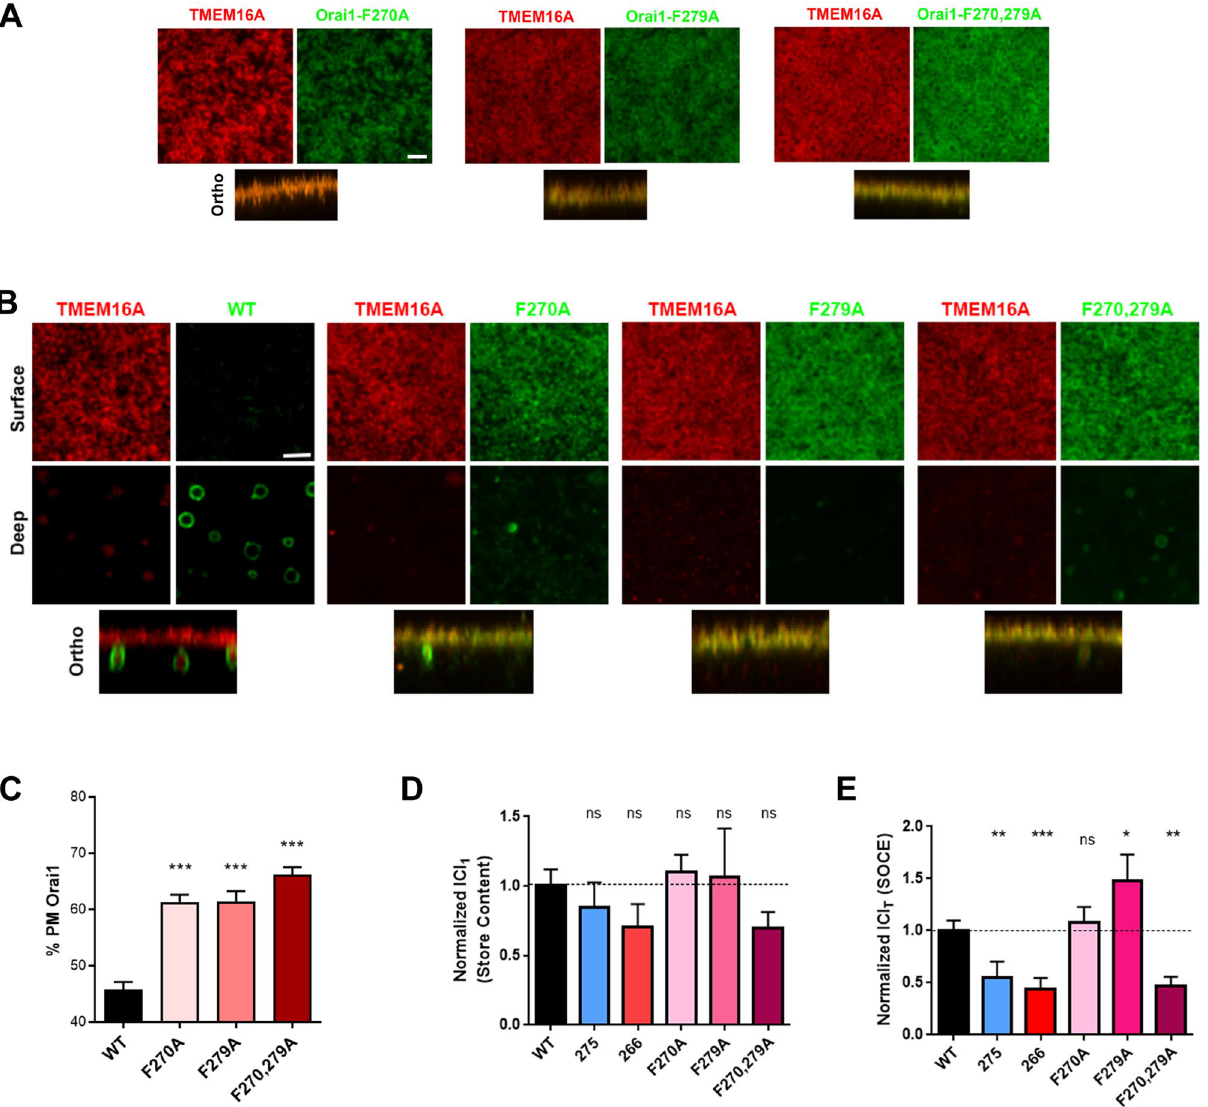
Figure 2. Internalization and functionality of the FXXΦ mutants. ( A , B ) Confocal images from oocytes ( A ) and eggs ( B ) expressing TMEM16A with GFP-Orai1 WT, F270A, F279A, or F270,279A mutants under similar conditions as in Fig. 1C and 1D. Scale bar is 3 µm. ( C ) Percent Orai1 at the PM (Mean ± SEM, n = 12–42 eggs from 9 donor females). ( C , D ) Normalized Cl 1 (I Cl1 ) ( C ) and Cl T (I ClT ) ( D ) currents from oocytes expressing STIM1 with the different Orai1 mutants as indicated (Mean ± SEM, n = 5–25 oocytes from 5 donor females). *(p < 0.05), **(p < 0.01), *** (p < 0.001), ns (not significant), one-way